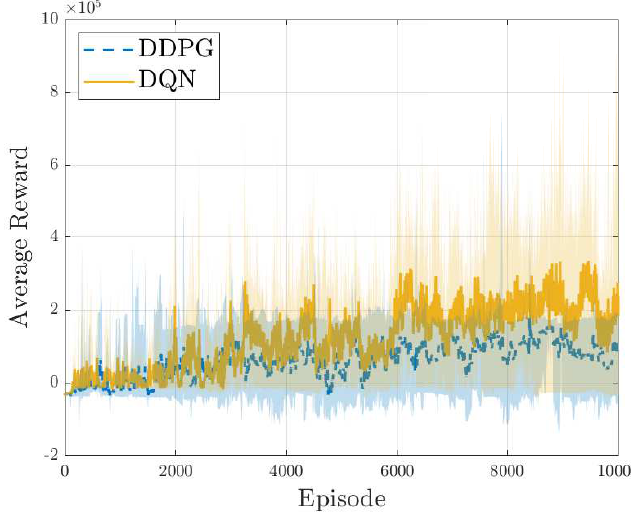
Figure 8. Convergence of the average reward per episode with episode number for the DQN and DDPG